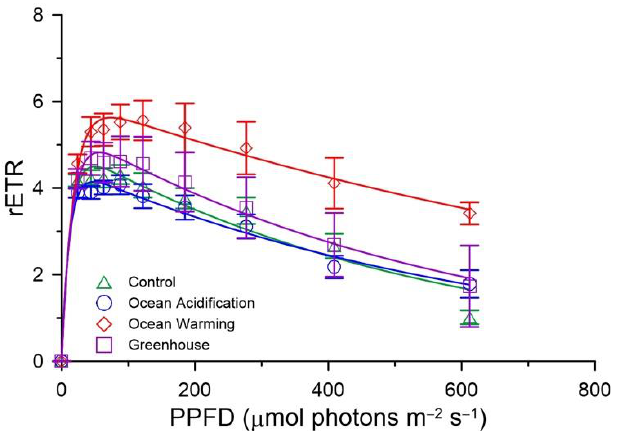
Figure 2. Relative electron transport rate (rETR) of Caulerpa sertularioides after exposure to present and three simulated future ocean conditions for 15 days. Data are represented as mean ± SE (n = 4). Table 2. Photosynthetic parameters of Caulerpa sertularioides from oxygen measurement (P-E curves) and chlorophyll-a fluorescence measurement (RLCs: rapid light curves) after 15 days under present and three future ocean conditions.